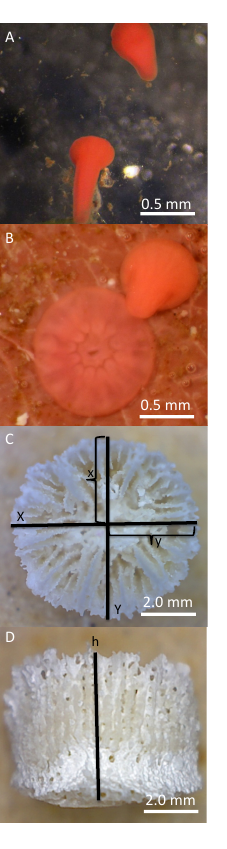
Fig. 1. Balanophyllia elegans planula larvae (a) , newly settled ju- veniles (b) , and a juvenile skeleton after 8 months of growth from above (c) , and in longitudinal section (d) . Skeletal measurements are indicated in (c) and (d) . The major and minor axes of the ellip- tical cylinder (X, Y) were measured with vernier calipers, and the major and minor radii (x, y) were calculated (c) . The height (h) was measured (d) and volume was calculated using Eq.